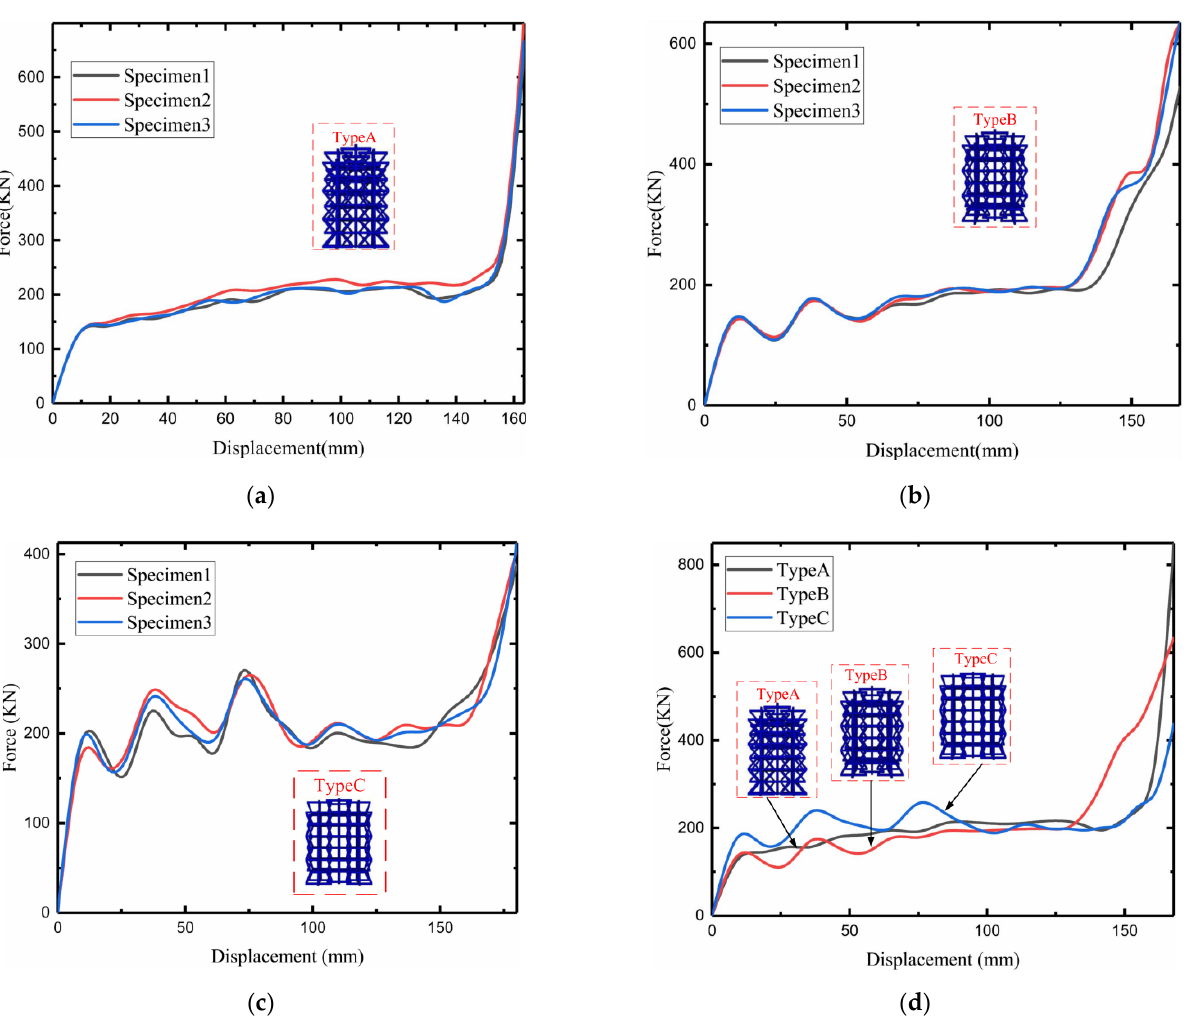
Figure 16. Load–displacement curve of numerical analogue: ( a ) type A load–displacement curve; ( b ) type B load–displacement curve; ( c ) type C load–displacement curve; ( d ) three types of fitting simulation load–displacement curves.